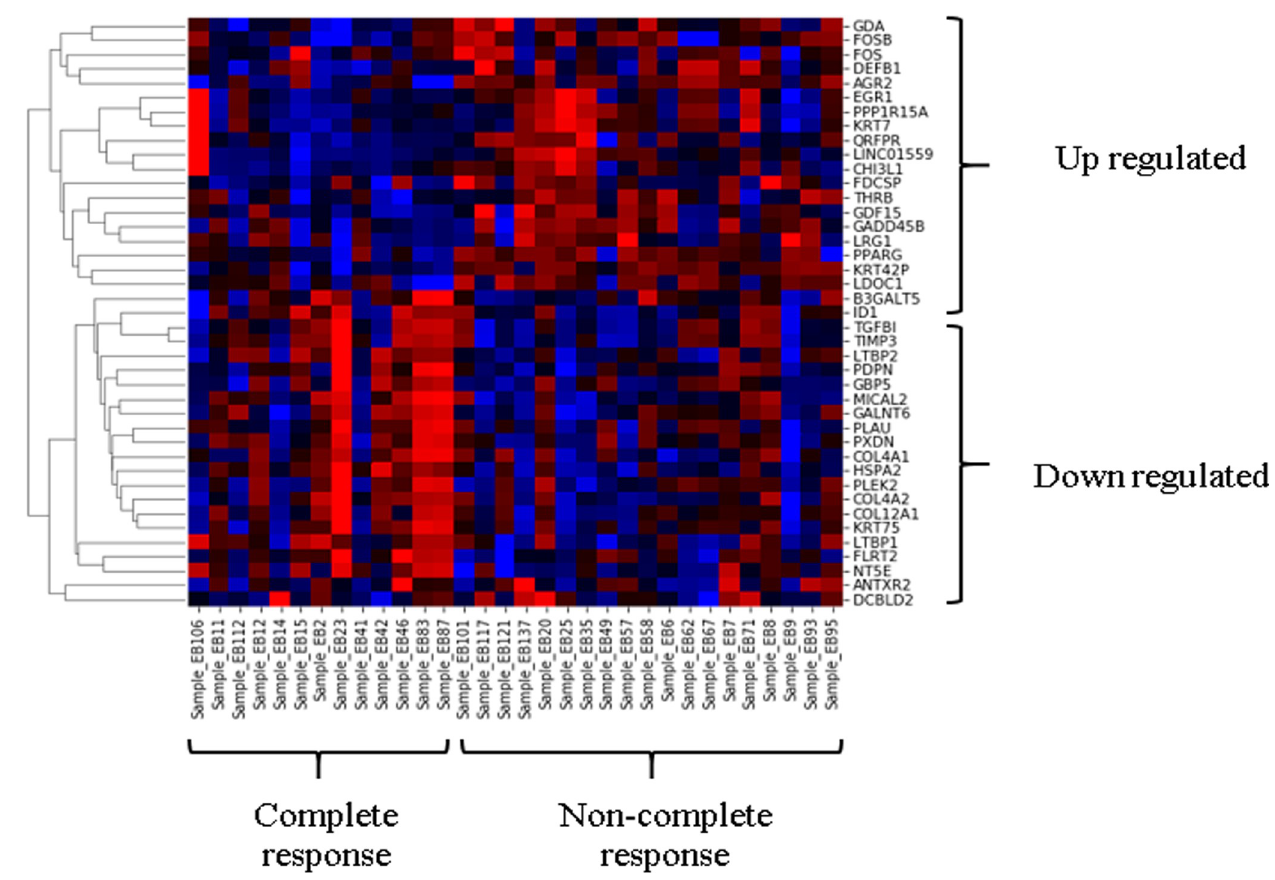
sequencing indicated that the 4 genes were significantly up-regulated in patients with non- complete response to nCRT compared with those with complete response (Fig 3). To deter- mine their possible risks for therapy progression in esophageal cancer patients, we plotted receiver operating characteristic curves (ROC) using read counts of RNA-Seq and therapy response of nCRT. Notably, the areas under the curves (AUCs) of AGR2 , GADD45B , PPP1R15A and LRG1 genes were 0.671, 0.529, 0.483 and 0.521, respectively (Fig 4). Results suggest that AGR2 gene was associated with therapy response of nCRT in esophageal cancer patients. Knockdown of AGR2 in esophageal cancer cells were more sensitive to the cytotoxicity effect of cisplatin and 5-fluorouracil Previous studies reported that AGR2 is involved in head and neck squamous cell carcinoma by regulating cell transformation and epithelial-mesenchymal transition (EMT) signaling path- ways [34], and that it also promotes tumor growth in esophageal adenocarcinoma [35]. In this study, we found that the AGR2 mRNA p-regulated in patients with non-complete response before nCRT. Therefore, we selected AGR2 for further investigation. We applied the siRNA approach to knockdown AGR2 expression in cell lines of esophageal cancer (CE146T/VGH, TE2, and CE48T/VGH) and then performed the MTT assay. Western blot analysis showed that protein levels of AGR2 were significantly reduced in CE146T/VGH, TE2, and CE48T/